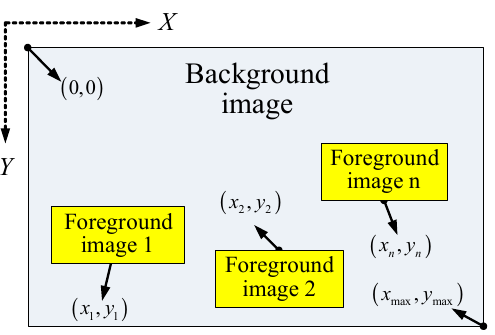
Figure 4. Definition of the coordinates in the monitoring screen of the simulated environment. Several foreground image objects can be distributed over the background image to show the exterior images of the object at the next level. Each foreground image object has a set of coordinates ( x n , y n ) in the background image. Managers can drag and drop an object by clicking the mouse button to select an object and then moving the mouse while keeping the mouse button pressed, so that the monitoring environment is proportionally reduced in the monitoring system to create a simulated environment. The design of the visualized monitoring interface comprises of three levels, as listed in Table 1. The background image is the image of the entire scene (M M ), which was obtained using the monitoring screen of Level 1 as an example. Users can upload multiple objects such as the image of a building exterior ( MAP i ) on the background image. The design concepts of the remaining levels BE are similar to those of Level 1. Thus, the configuration of the simulated environment can be displayed on a monitoring screen. Table 1. Simulated environment.